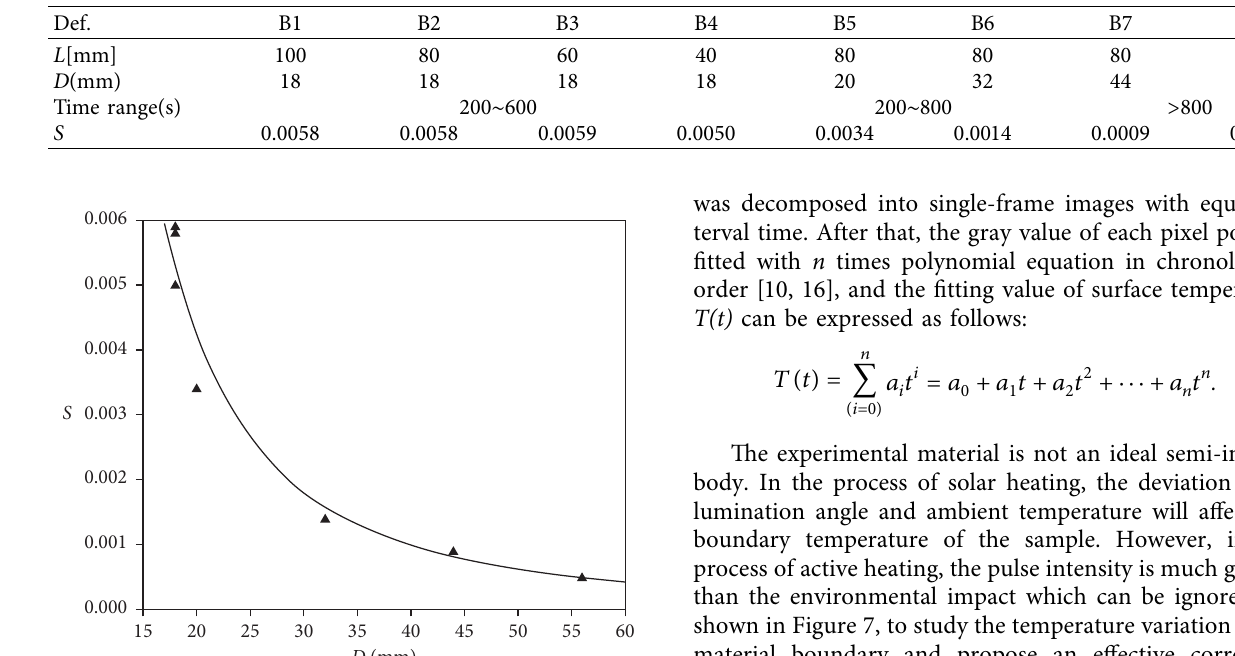
Figure 5: Ratio fitting. Table 2: Growth rate of temperature difference.